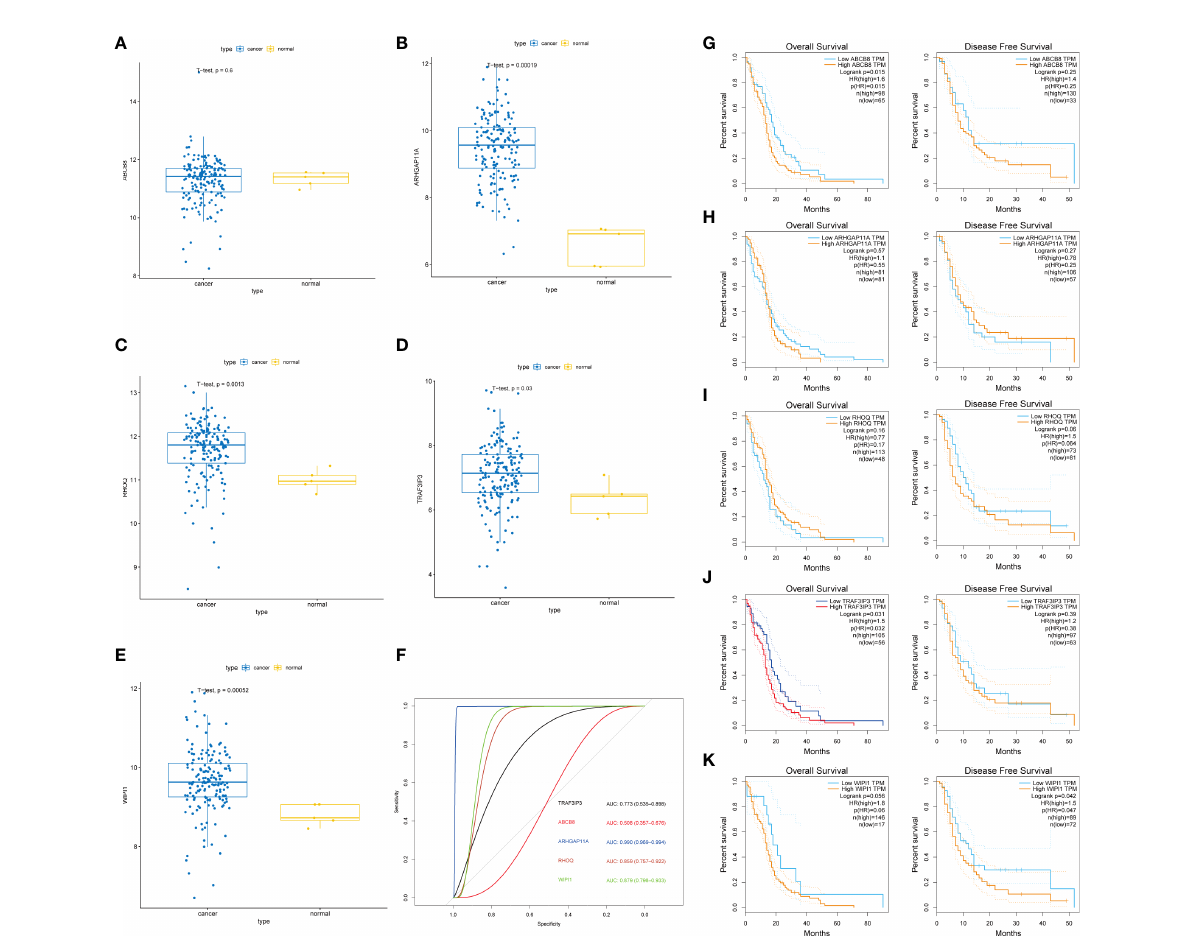
FIGURE 3 Key genes and their prognostic value. (A – E) The differential expression of fi ve key genes in normal and tumor tissue. (F) ROC curve and AUC value of fi ve key genes in normal and tumor tissue. (G – K) The impact of the expression of the fi ve key genes in tumor tissue on the OS and DFS of patients and their signi fi